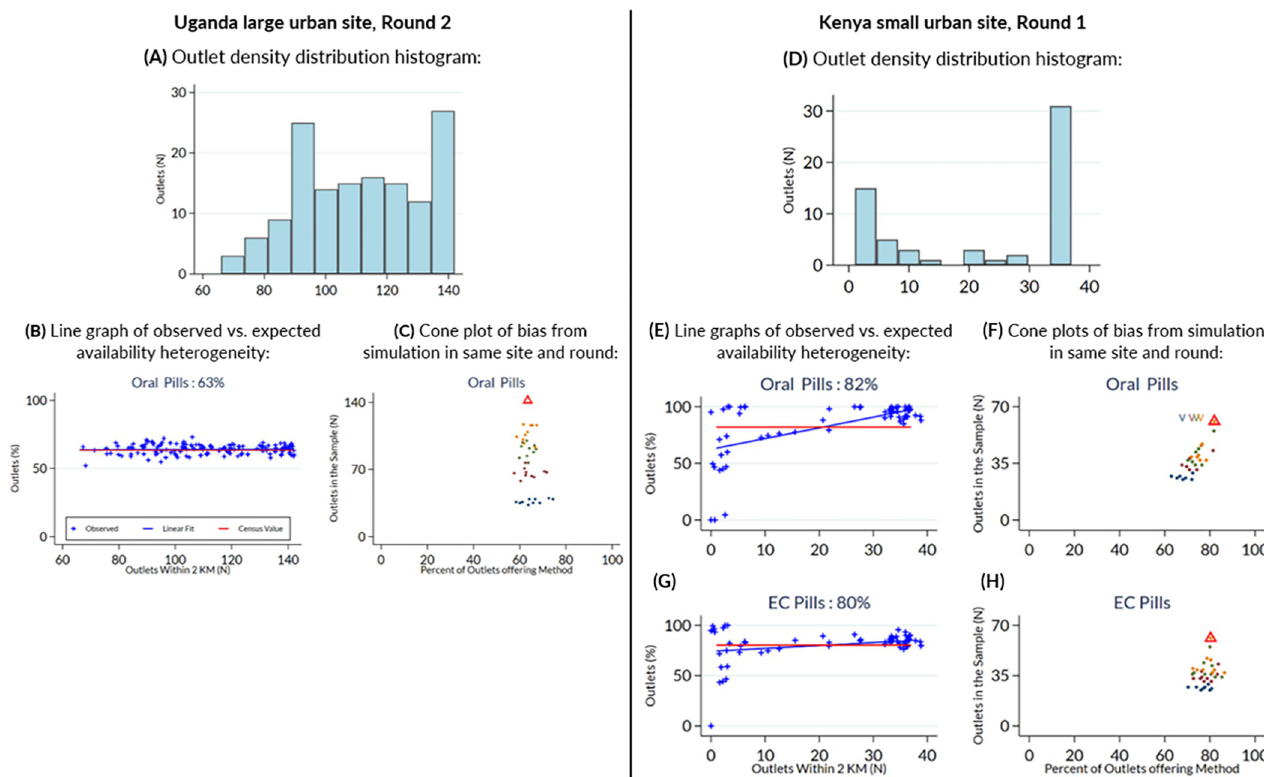
Fig 5. Bias as a function of outlet concentration and heterogeneity in product availability. In the left panel, outlet density is more constant than in many distributions ( A ), but the availability of OCP does not vary with density ( B ), and sampling bias is therefore low ( C ). In the right panel, outlet density varies more starkly, producing a clearly bimodal distribution ( D ). When product availability is heterogeneous ( E ), bias is seen in the simulation cone plot ( F ). When product availability is homogenous ( G ), bias is not seen in the simulation cone plot ( H ). Bias in the simulated results requires both outlet density heterogeneity and product availability